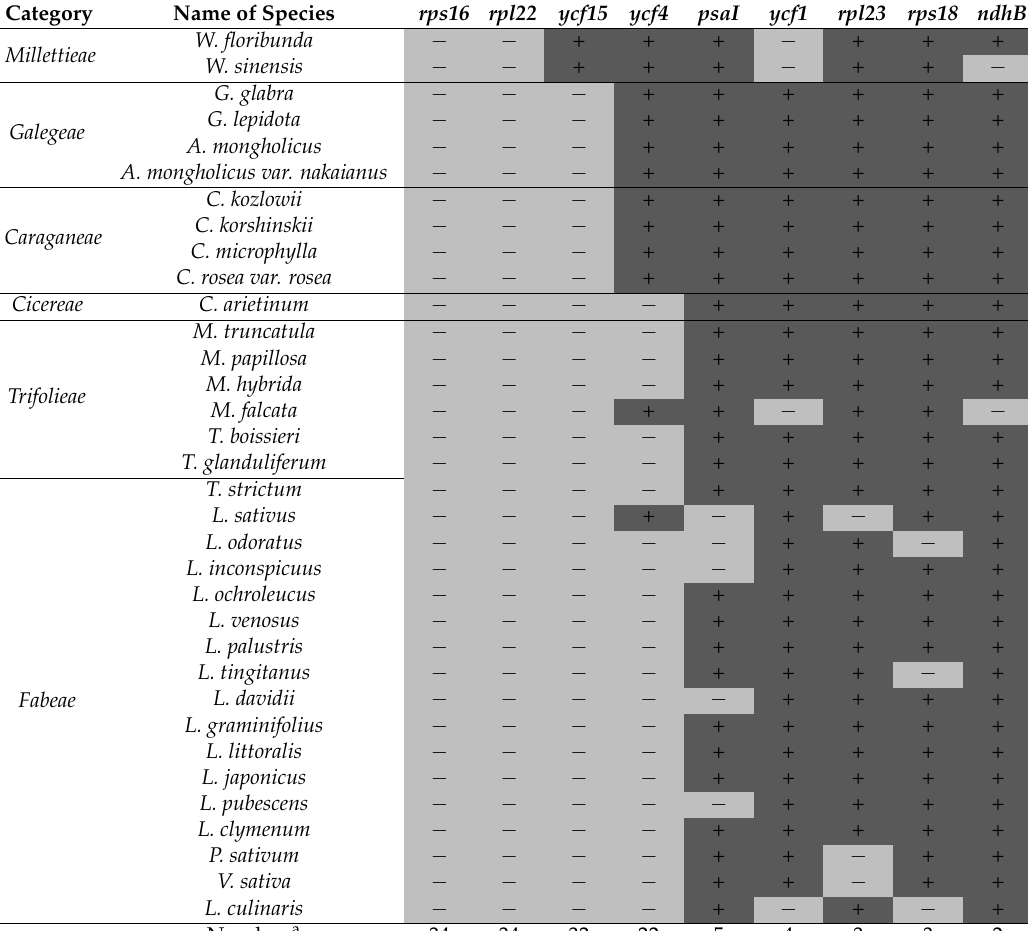
Table 2. Gene losses in the plastomes from the inverted-repeat-lacking clade (IRLC) of Papilionoideae.